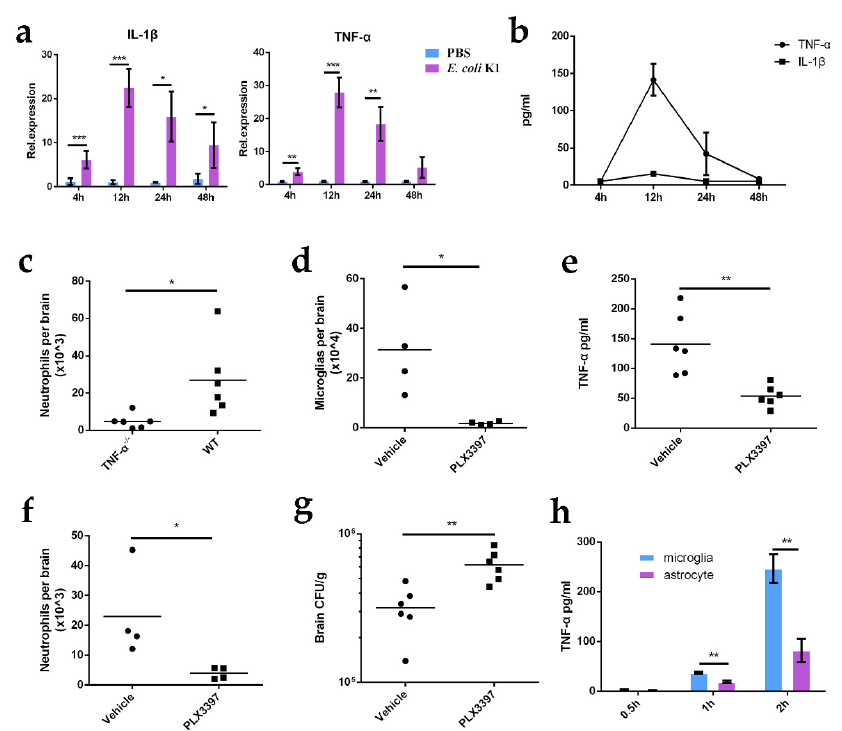
Figure 2. E.-coli -K1-induced neutrophil recruitment requires TNF- α , microglia-derived pro-inflam- matory cytokine. ( a ) Real-time quantitative PCR analysis of TNF- α and IL-1 β mRNA levels in unin- fected mouse brains and those infected with E. coli K1 for 4, 12, 24, and 48 h ( n = 6 mice per group). ( b ) ELISA analysis of TNF- α and IL-1 β protein levels in E.-coli -K1-infected brain 4, 12, 24, and 48 h post-infection ( n = 6 mice per group). ( c ) Neutrophil counts in the brains of wild-type (WT) mice and TNF- α -deficient mice infected with E. coli K1 for 24 h ( n = 6 mice per group). ( d – g ) Mice were pretreated with PLX3397 or vehicle (negative control) for 2 weeks and then infected with E. coli K1 for 24 h. Thereafter, the microglia count ( d , n = 4 mice per group), TNF- α protein levels (e, n = 6 mice per group), neutrophil counts ( f , n = 4 mice per group), and bacterial loads ( g , n = 6 mice per group) in the mouse brain were analyzed. ( h ) Primary microglia and astrocytes were stimulated with E. coli K1 for 0.5, 1, 2 h, and the production of TNF- α was assessed using ELISA. Data are presented as mean ± SD, n = 3 independent experiments. p values were determined using Student’s t -test ( a , h ) or Mann–Whitney U test ( c – g ). * p < 0.05; ** p < 0.01; *** p < 0.001.